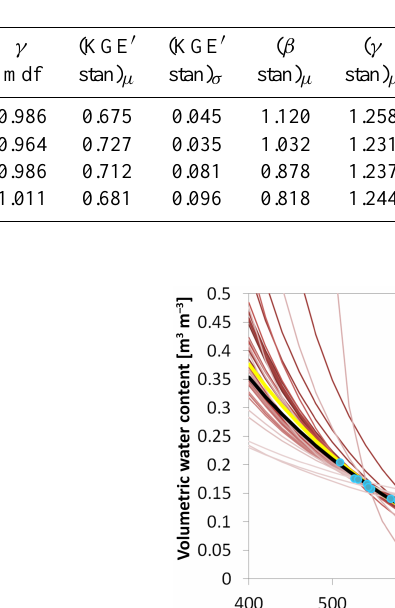
Table 7. Performance measures for the four weighting approaches – comparison of modified calibration (mdf) with standard calibra- tion (stan). KGE (cid:48) is the modified Kling–Gupta efficiency, β is the bias ratio and γ is the variability ratio. (KGE (cid:48) ) µ and (KGE (cid:48) ) σ represent the mean and standard deviation of the KGE (cid:48) values of the 10 individual single-point standard calibrations.